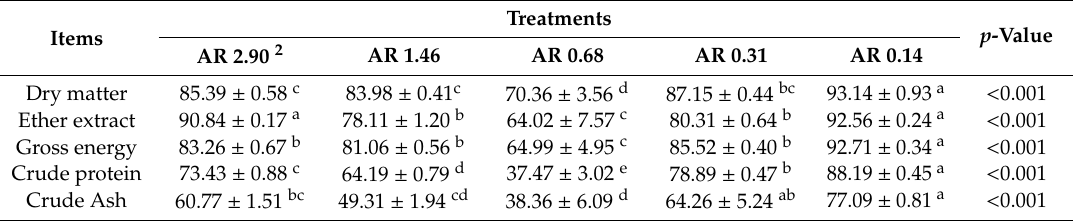
Table 7. E ff ects of dietary starch structure on apparent total tract digestibility in weaned piglets (mean values with their standard errors) 1